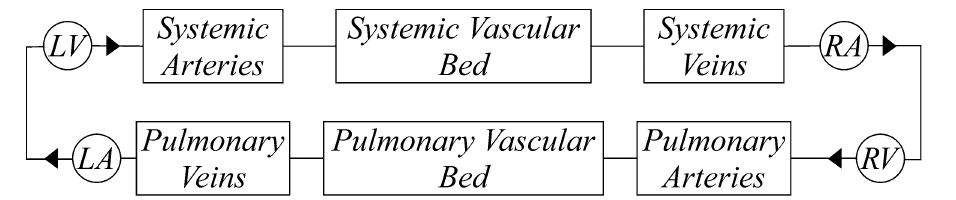
Figure 1. Circulation model composed of: left ventricle (LV), systemic arteries, vascular bed, and veins, right ventricle (RV), right atrium (RA), pulmonary arteries, bed, and veins, left atrium (LA) and heart valves ( ▸